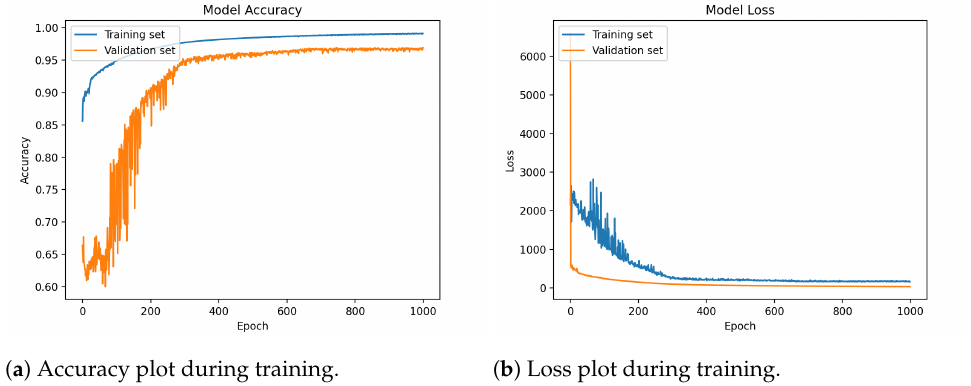
Figure 8. Two plots above show the performance of a deep learning model on a training and validation dataset during the training process. The plots show both accuracy and loss metrics, which are common measures of a model’s performance. The accuracy plot shows how accurately the model is able to classify the images in the training and validation datasets as it is trained. As the model is trained, the accuracy on both the training and validation datasets is expected to slowly increase, indicating that the model is learning to classify the images more accurately. Eventually, the accuracy may reach a point of overfitting, where the model is able to classify the training data with high accuracy but is no longer able to generalize well to new, unseen data. This is typically indicated by a decrease in accuracy on the validation dataset. In the end, the model reaches a per-pixel accuracy of over 99%. The loss plot shows the error of the model as it is trained. As the model learns to classify the images more accurately, the loss should decrease, indicating that the model is making fewer errors. Overall, the provided deep learning model is performing well on the training and validation datasets, steadily increasing accuracy and decreasing loss as it is